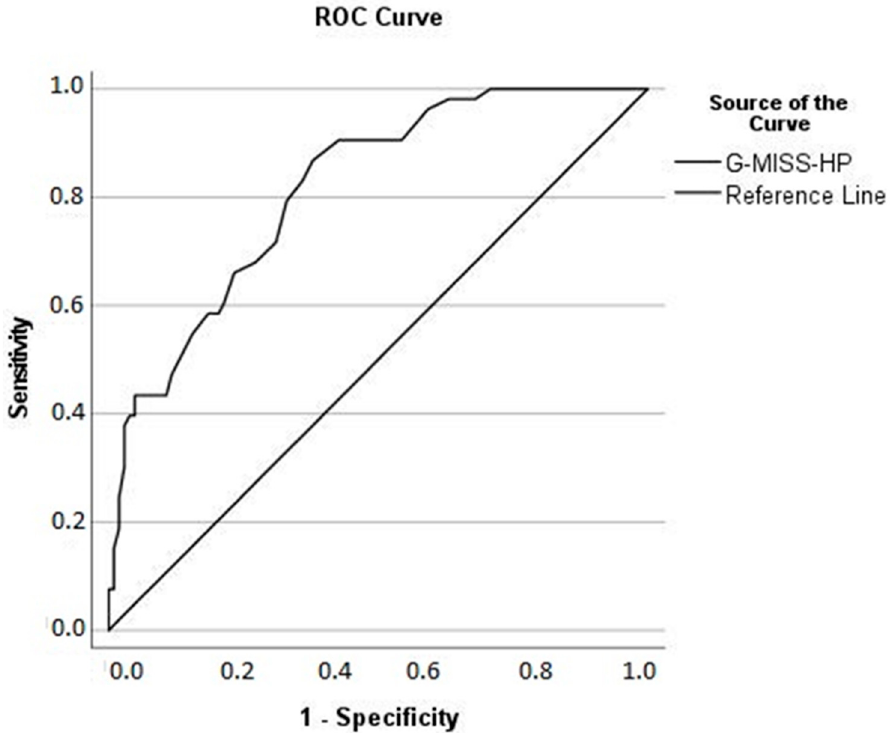
Figure 4. Receiver operator curve (ROC) for G-MISS-HP.